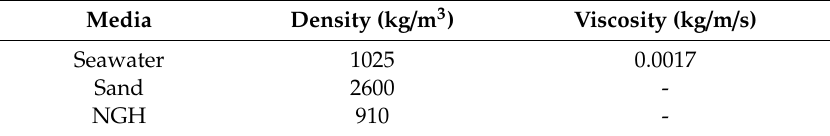
Figure 5. The BT-9300LD dry wet laser particle size analyzer ( a ) and diagram of sediment particle size distribution ( b ). Table 2. Physical parameters of media.